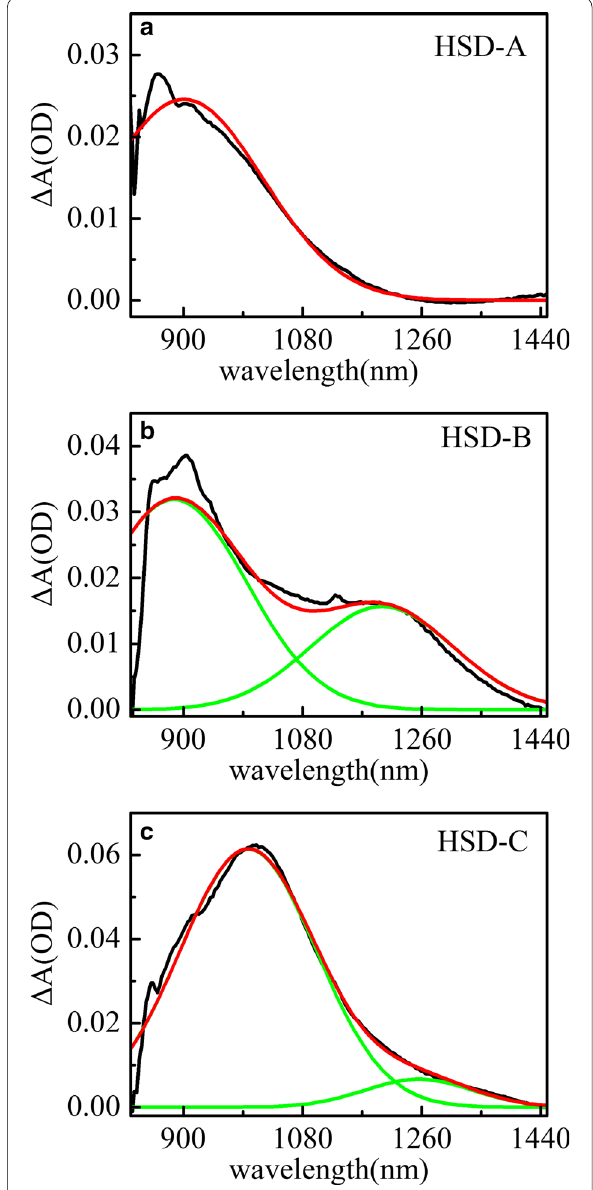
Fig. 5 Transient absorption spectral peak-fitted of HSD-A ( a ) and HSD-B ( b ) and HSD-C ( c ) at the delay time of 2 ps in the infrared range. Black curve represents the absorption spectrum of the samples at 2 ps, red curve is the fitted absorption spectrum, and the green is the spectral signal identified in the